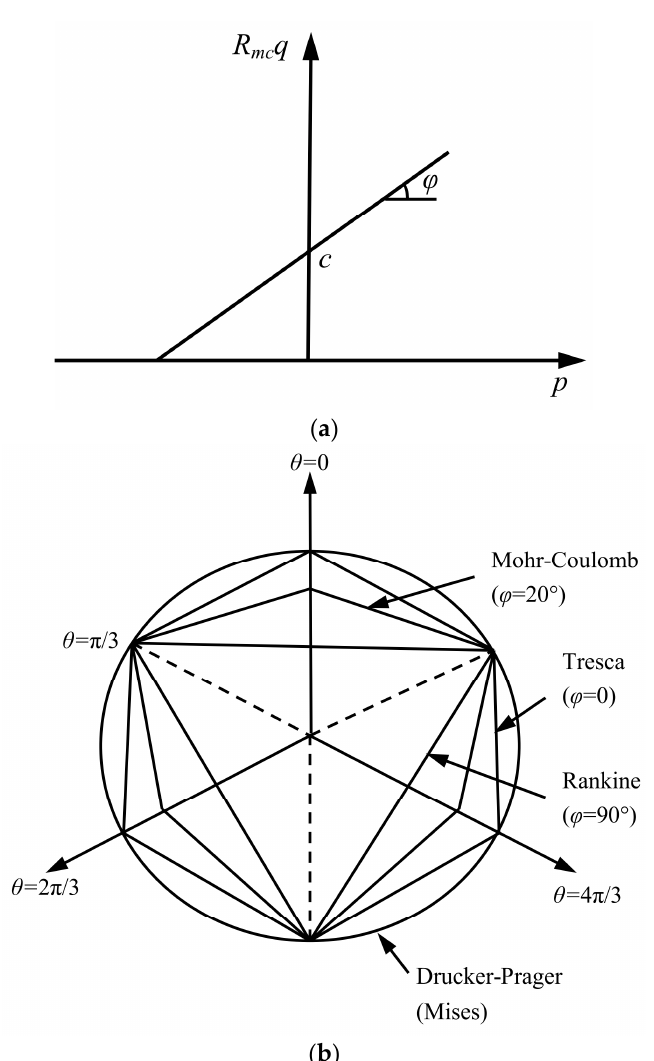
Figure 4. Yield surface of the Mohr ‒ Coulomb model. ( a ) Mohr–Coulomb yield surface on the π surface. ( b ) Comparison of the Mohr ‒ Coulomb yield surface with other constitutive yield surfaces.